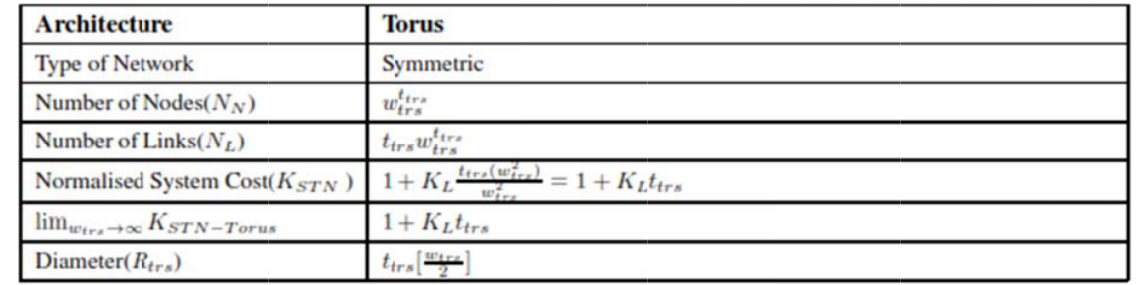
Table 1: Summ 8. Master-S Ring